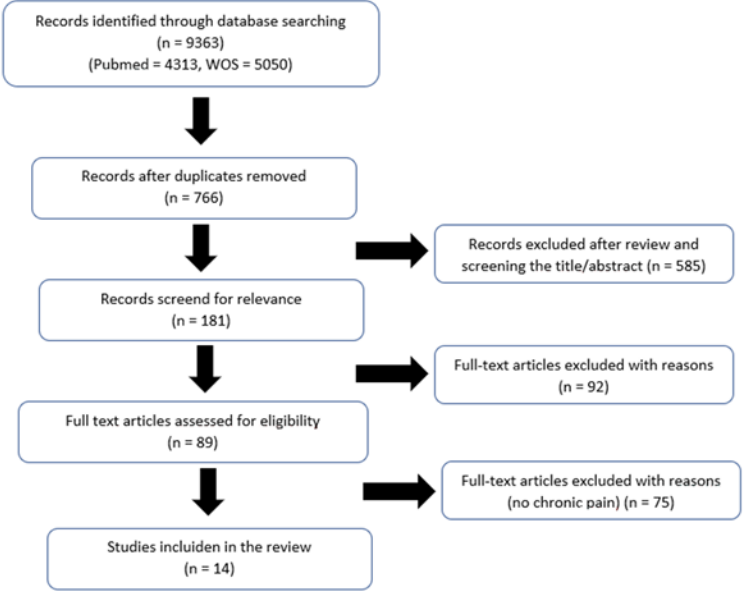
Figure 1. Systematic review flowchart.